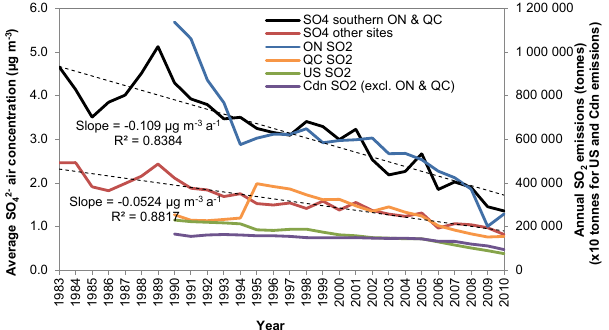
Figure 4. Temporal trends of annual average atmospheric SO − annual SO 2 emissions. ON and QC refer to the province of Ontario and Québec, respectively. Between 1990 and 2010, atmospheric SO − decreased by 4.5% at southern Ontario (ON) and Québec 4 (QC) sites and by 3.6% at other sites. Over the same period, SO 2 emissions decreased by 1.8% in Canada (Cdn) and 4.3% in the USA.